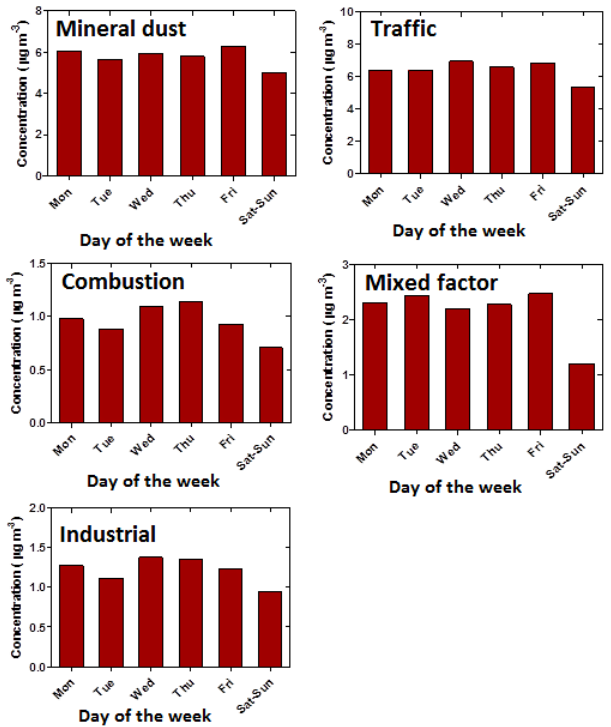
Figure 15. Weekly series of the five factors obtained from the PMF analysis of sampled PM 2 . 5 . The difference between weekdays and weekends highlights the anthropogenic contribution to air pollution in Nairobi. The mixed factor is attributed to contribution from aged sea salt, biomass burning and secondary